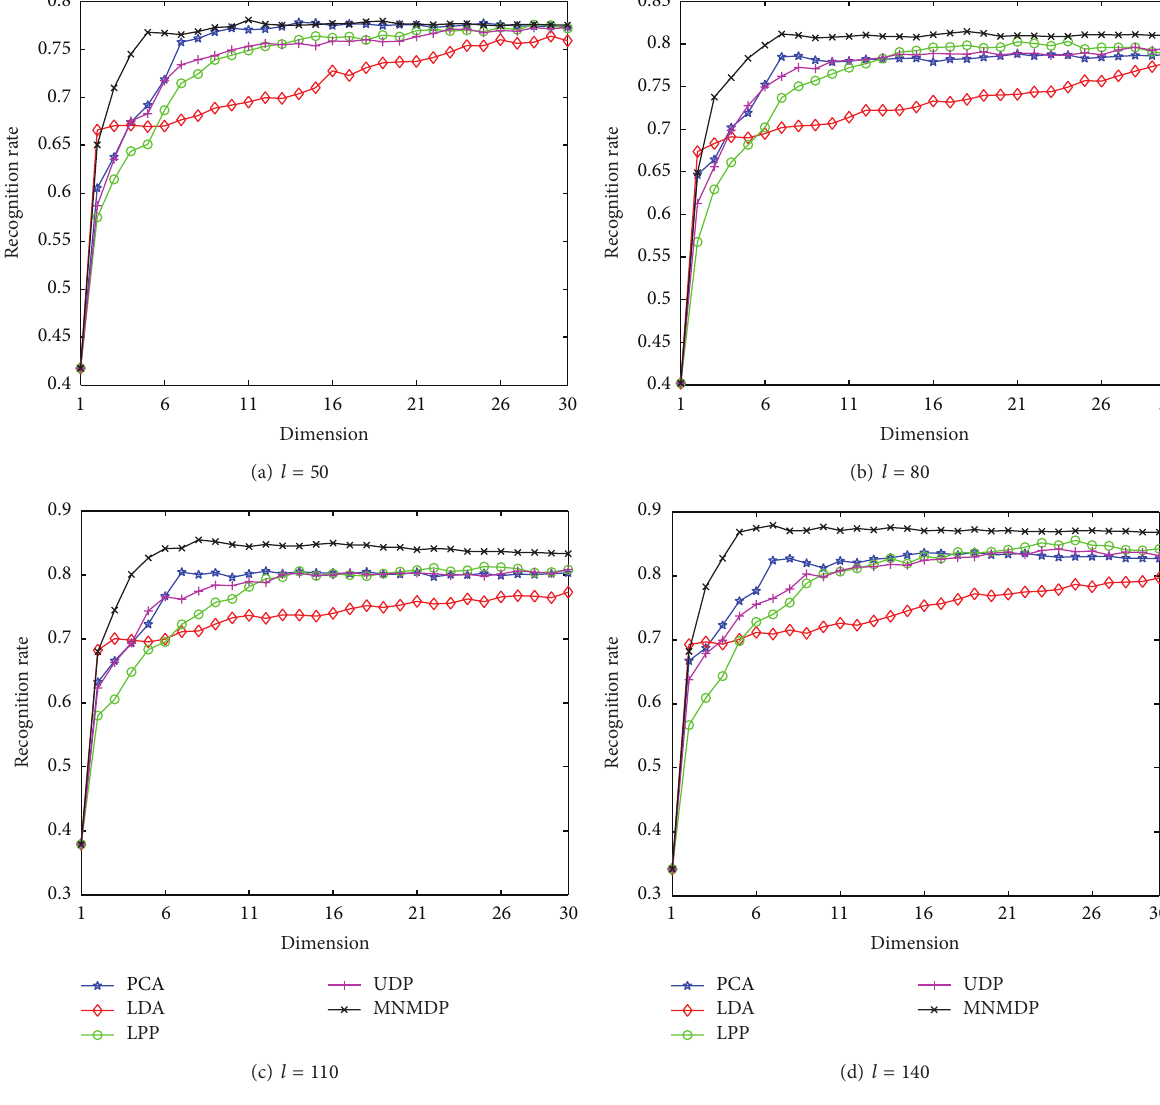
Figure 11: The average recognition rates versus dimension on